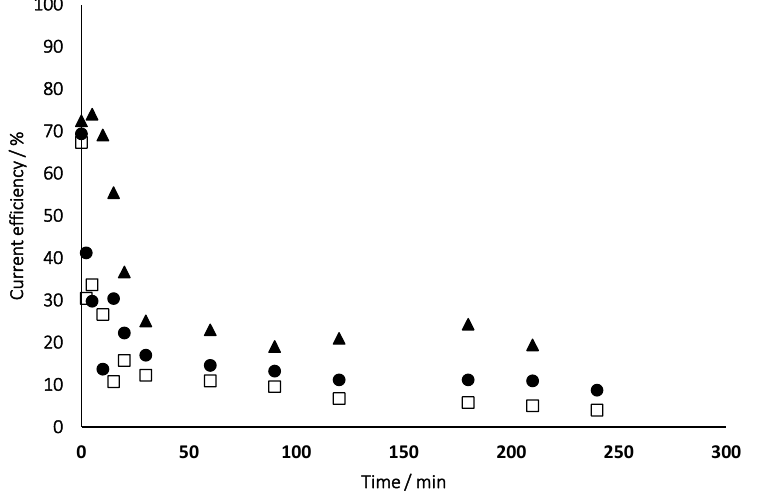
Figure 4. Changes in the current efficiency during the electrolysis of 17 β -estradiol in synthetic urine/methanol system with BDD anodes at different current densities and at 6.77 mL·s − 1 of flowrate. Current density: ( ▲ ) 20 mA·cm − 2 ; ( □ ) 50 mA·cm − 2 ; ( ● ) 100 mA·cm − 2 .